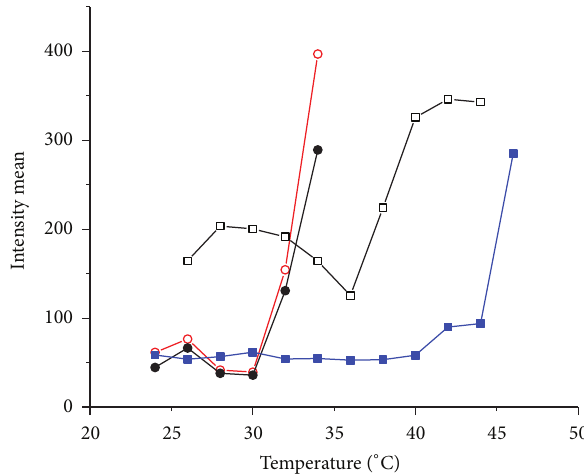
Figure 5: LCST of star polymers: star polymer [(PNIPAAm- b - polyHA) 1 -EGDMA 10 ] in PBS at pH 7.4 ( e ) and in PBS at pH 6 ( I ); star polymer [poly(NIPAAm- co -4MBA)- b -polyHA] 1 -EGDMA 10 in PBS at pH 6 ( ◻ ) and in PBS at pH 7.4 ( ◼